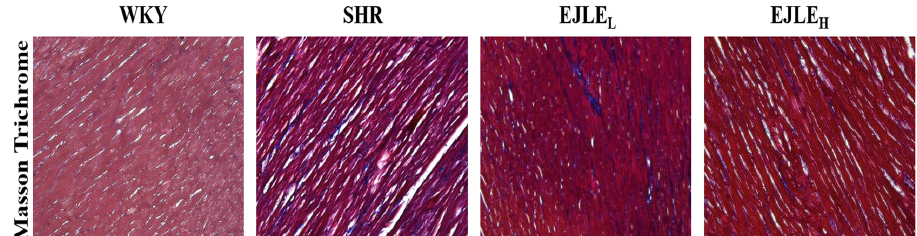
Figure 5. Effect of EJLE on fibrosis in the heart of SHR animals. Representative Masson’s trichrome photomicrograph depicting the effect of EJLE on the heart tissue sections of normotensive rats (WKY), spontaneously hypertensive rats (SHRs) and SHRs supplemented with low dose (EJLE L ) and high dose (EJLE H ) of EJLE. The heart tissue sections from all animals were processed for Masson’s trichrome staining as detailed in the materials and methods and images were acquired through microscope at 400× magnification .